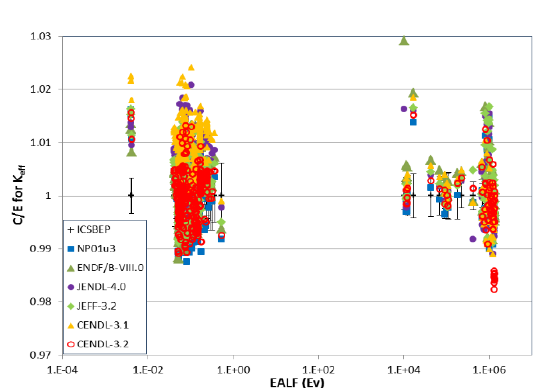
Fig. 21 . Results for LEU systems